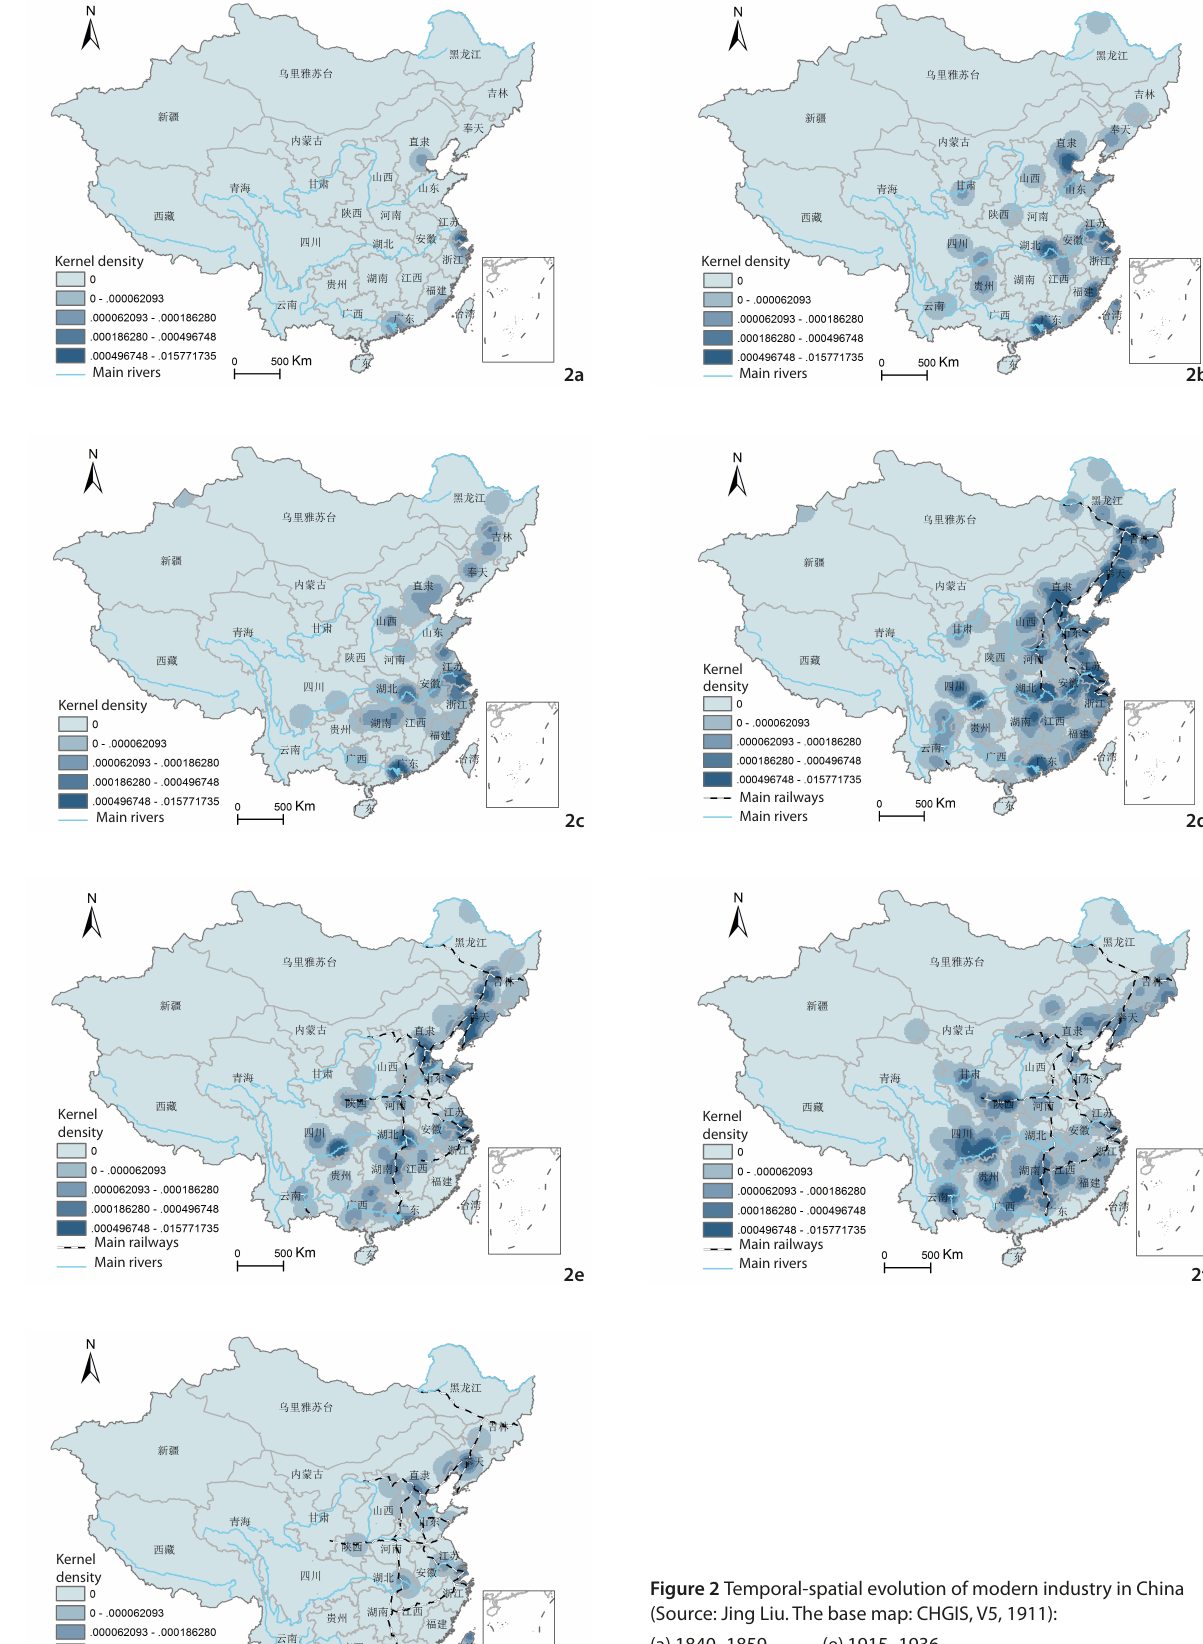
Figure 2 Temporal-spatial evolution of modern industry in China (Source: Jing Liu. The base map: CHGIS, V5,